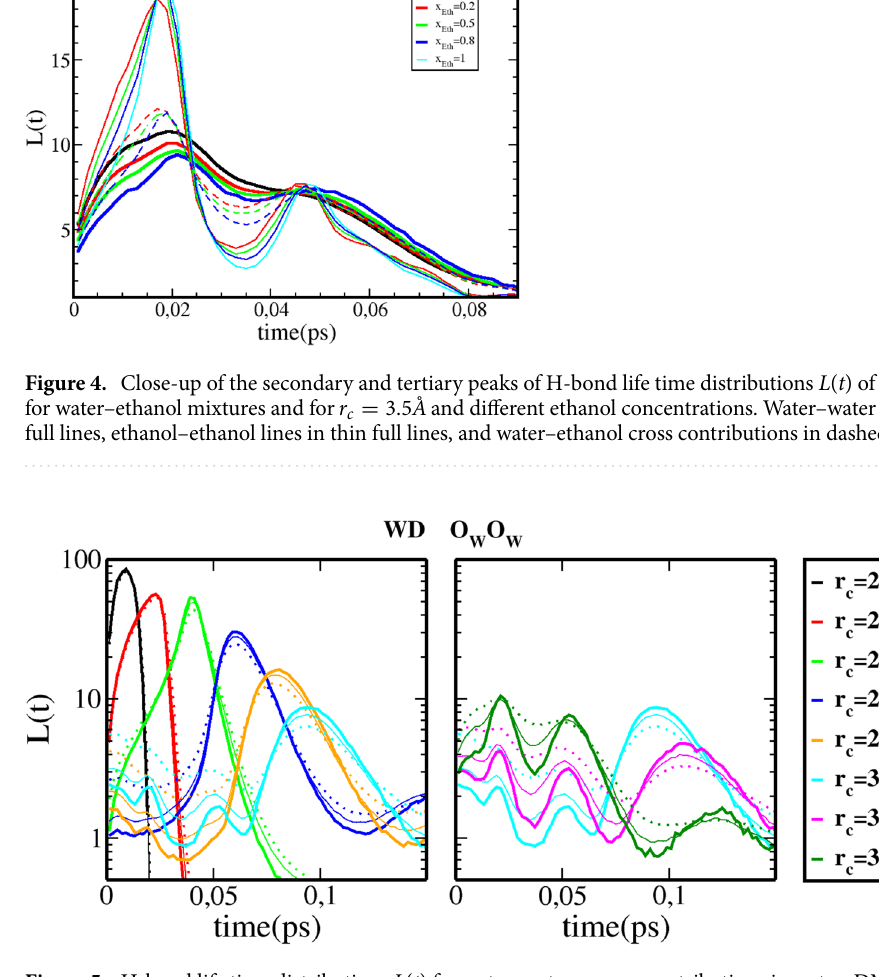
Figure 5. H-bond life time distributions L ( t ) for water–water oxygen contributions in water–DMSO mixtures. Line style versus solute concentrations are the same as in Figs. 2, 3. Complementary informations in Fig. 2B of the SI